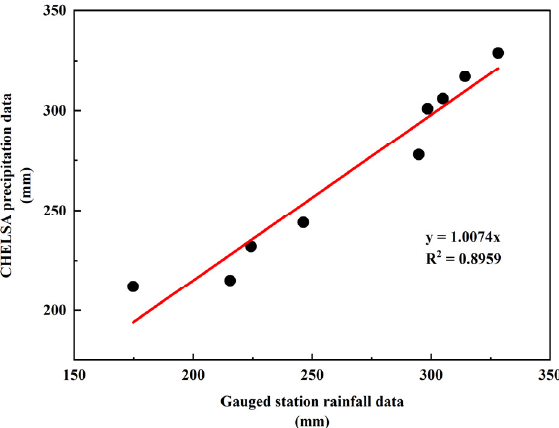
Figure 2. Relationship between the CHELSA precipitation data with gauged station rainfall